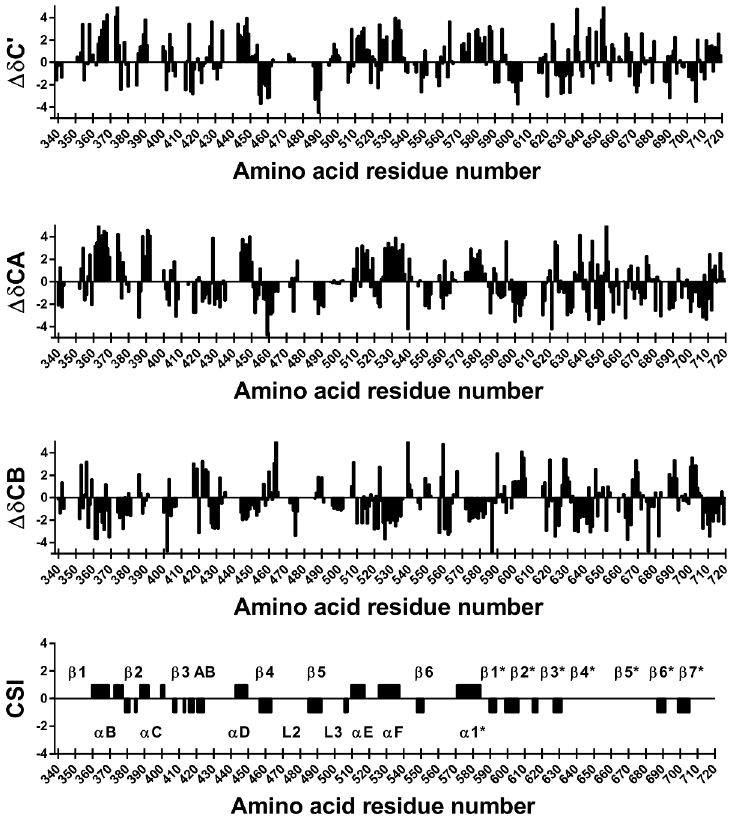
Fig 3. Estimate of the secondary structure in MALT1 Casp-Ig3 (338 – 719). Secondary chemical shifts ( Δδ ) were calculated by subtracting random coil chemical shifts corrected for nearest-neighbour effects from 13 C ’ , 13 C α and 13 C β chemical shifts corrected for deuterium isotope shifts. Consecutive values above 0.7 indicates alpha helix, while consecutive values below -0.7 indicates beta strand for Δδ 13 C ’ and Δδ 13 C α . The opposite is true for Δδ 13 C β . The CSI for the three nuclei were averaged and reported as a “ consensus ” CSI. β 3, β 3A and β 3B are denoted β 3 AB in the Fig. The star ( * ) indicates that the secondary structure is part of the Ig3 domain.